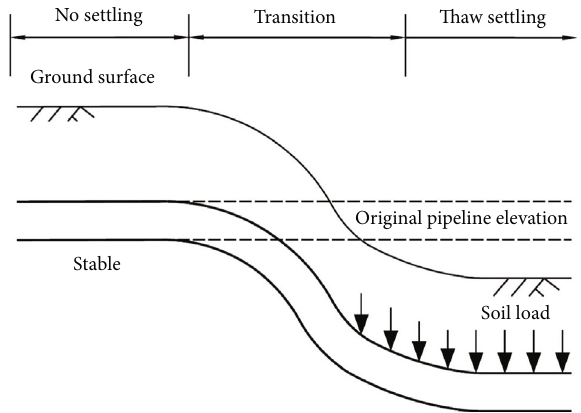
Figure 4: Chart for di ff erent thaw settlements along the pipeline. Figure 5: Typical void ratio versus pressure curve for frozen soils subjected to thawing